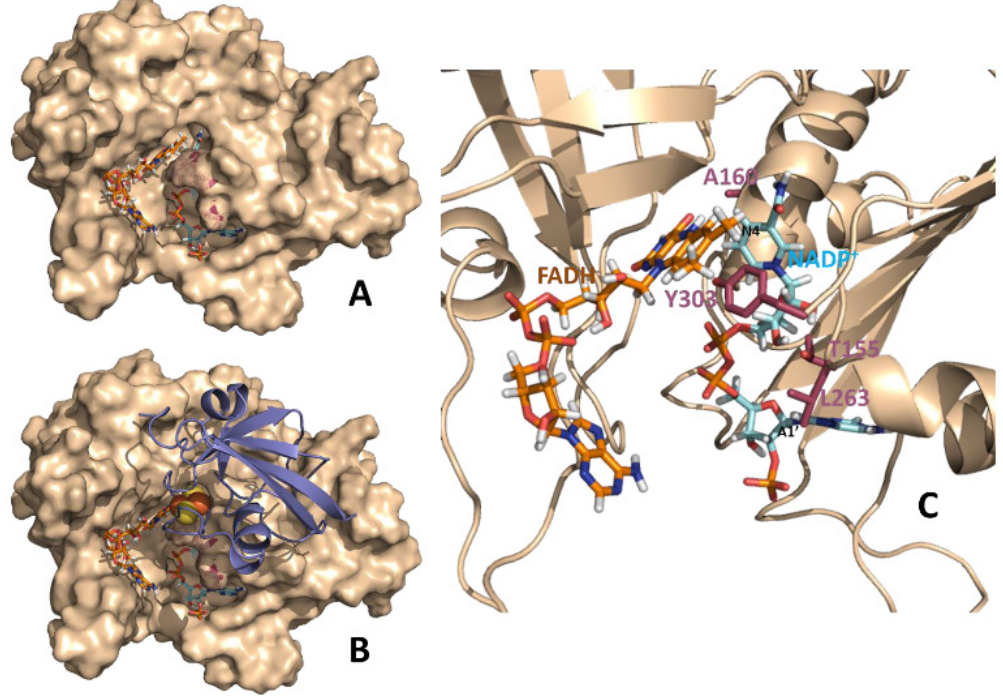
Figure 1. Theoretical models for binary FNR:NADP + and ternary Fd:FNR:NADP + complexes from Anabaena . ( A ) Structural model at the equilibrium of the molecular dynamics simulations of a catalytically competent complex between reduced FNR and NADP + [14]. ( B ) Structural model for the Fd:FNR:NADP + ternary complex. The model has been constructed by structural alignment of the equilibrium molecular dynamics + FNR:NADP complex ( A ) with the crystal structure of the Fd:FNR complex (PDB 1ewy) [24]. C . Detail of the relative disposition between the NADP + coenzyme and the FAD cofactor in the binary FNR:NADP + complex. The polypeptide chain of FNR is shown in wheat (in A and B as surface and in C as cartoon). FAD and NADP + are represented in sticks with carbons in orange and blue, respectively. N4 and A1’ positions of NADP + are black labeled to help orientating the molecule. In B Fd is shown in violet cartoon with its iron-sulphur cluster in spheres. Residues mutated in this work are highlighted in raspberry either as surface dots ( A and B ) or CPK sticks ( C